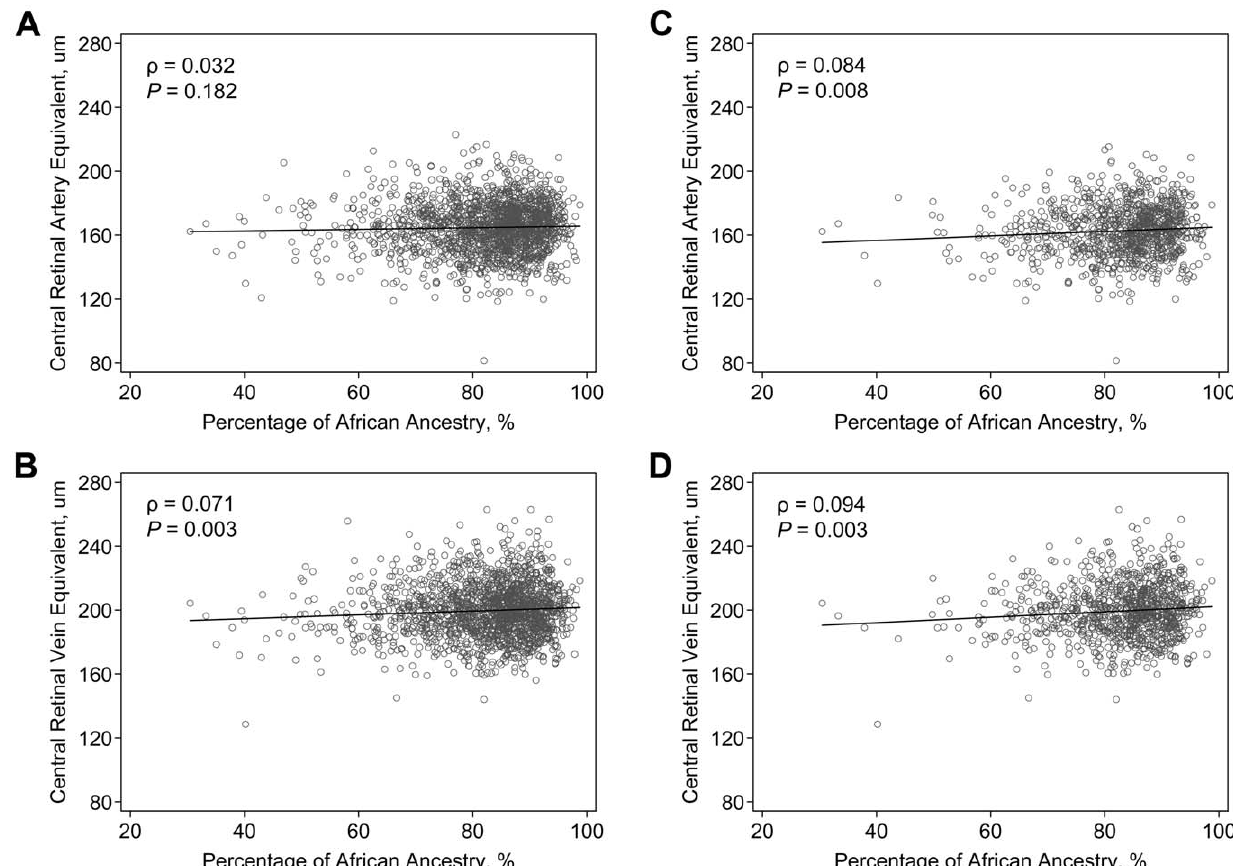
Figure 1. Correlation of retinal vascular calibers and the estimated percentage of African ancestry in the ARIC African Americans. Data are scatter-plotted for (A) central retinal artery equivalent in all individuals, (B) central retinal vein equivalent in all individuals, (C) central retinal artery equivalent in hypertensive individuals, and (D) central retinal vein equivalent in hypertensive individuals. The solid black line in the figure is a linear regression line.